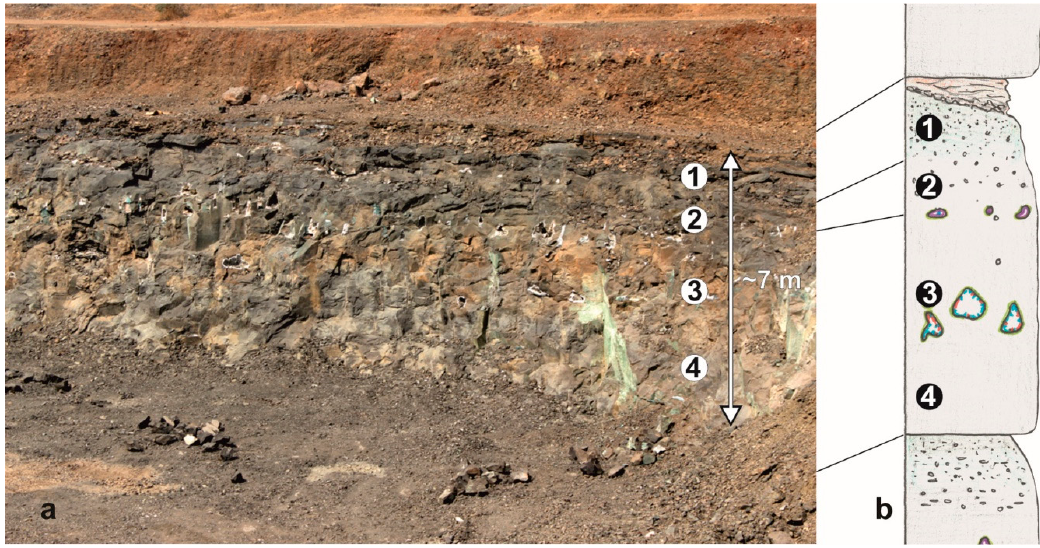
Figure 4. Structure of a basalt flow in the quarries of Savda. ( a ) Rock wall in the quarry (about 7 m high). ( b ) Schematic column of the flow. The individual flows (Figure 4a,b) are subhorizontal and